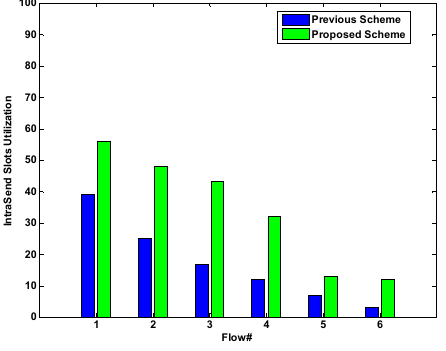
Figure 9. IntraSend slot utilization.